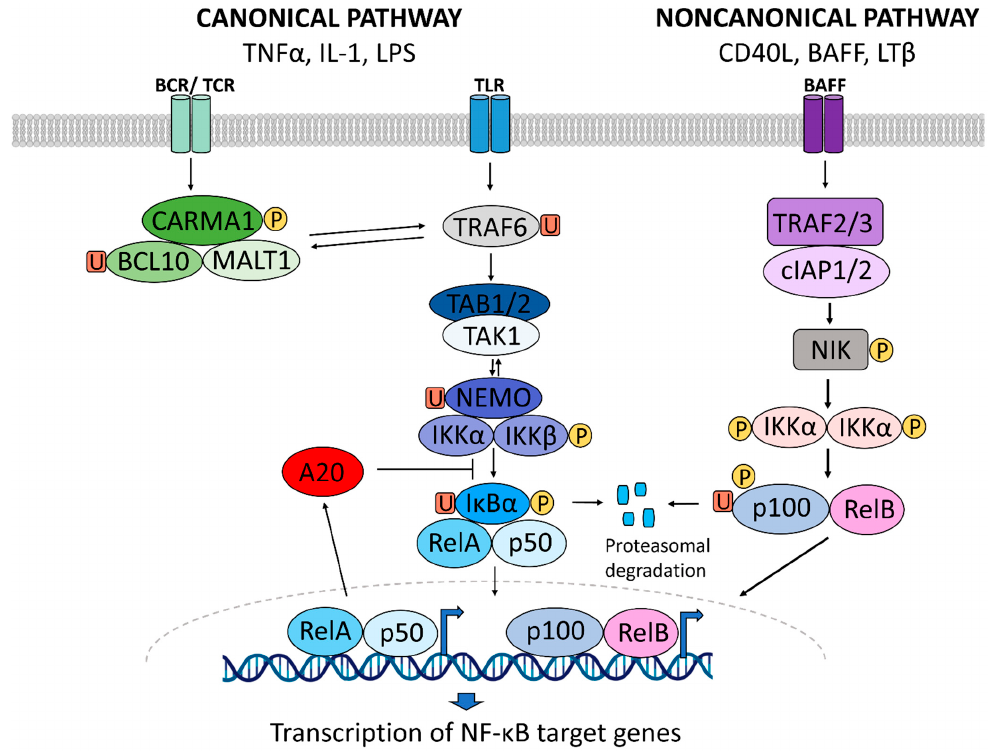
Figure 1. Activation of the canonical and noncanonical NF- κ B signaling